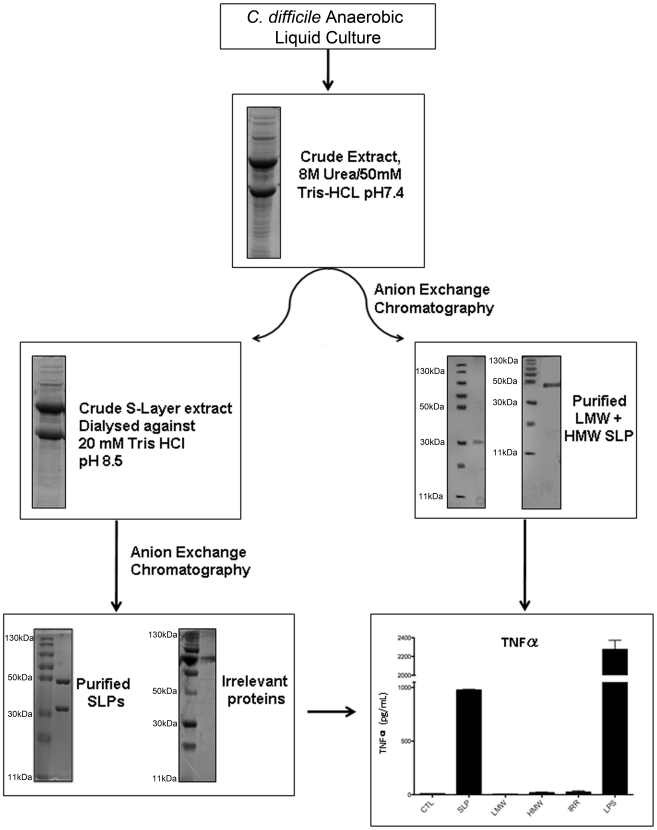
Purification and characterisation of SLPs isolated from C. difficile.Coomassie blue stained 12% SDS-PAGE gel showing crude extracts and purified C. difficile SLPs at each stage of the purification process. Individual high molecular weight (HMW) and low molecular weight (LMW) proteins and an irrelevant protein from the same process are also shown. Bone marrow derived DCs were isolated from Balb/C mice and incubated with either SLPs (20 µg/mL), LMW (20 µg/mL), HMW (20 µg/mL) or an irrelevant protein (20 µg/mL) for 24 h. LPS (100 ng/ml) was used as a positive control. The concentration of TNFα was measured in the supernatants by ELISA. The results are the mean (±SEM) for n = 4. *** p<0.001, determined by one-way ANOVA test comparing all groups.